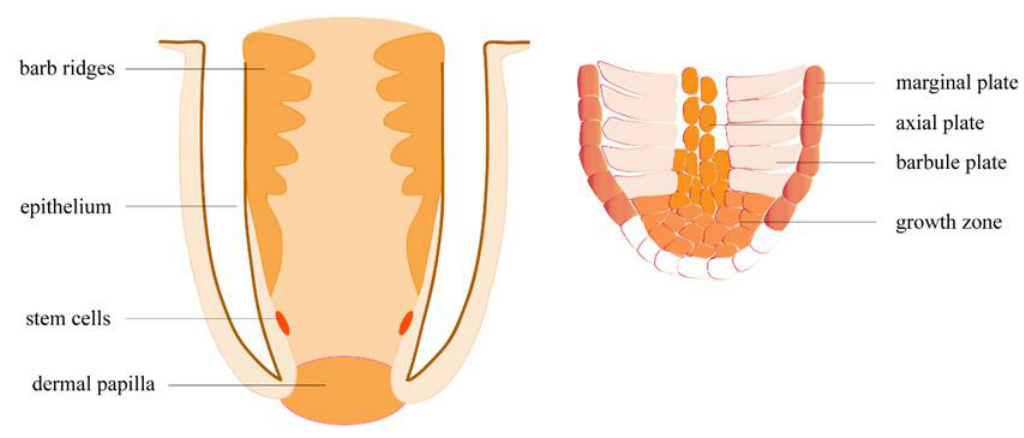
Figure 5. Follicle structure during feather regeneration.